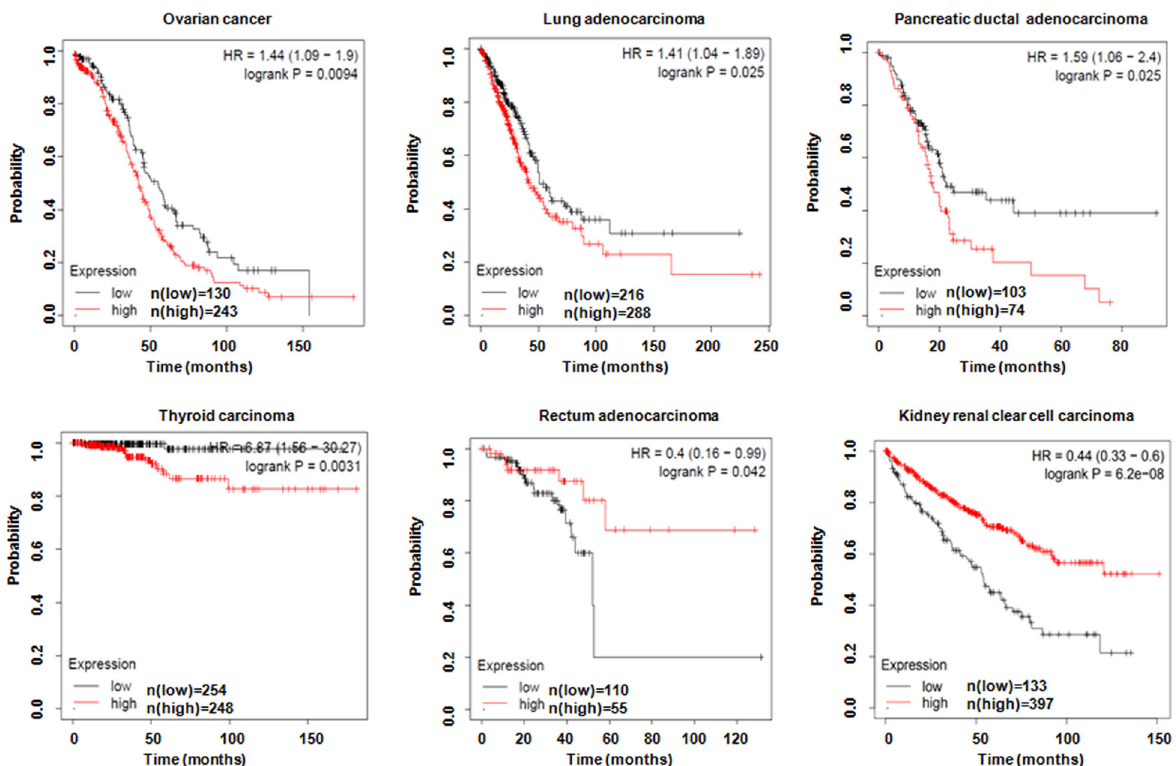
Fig. 2 WWP1 expression is associated with overall survival in a variety of human